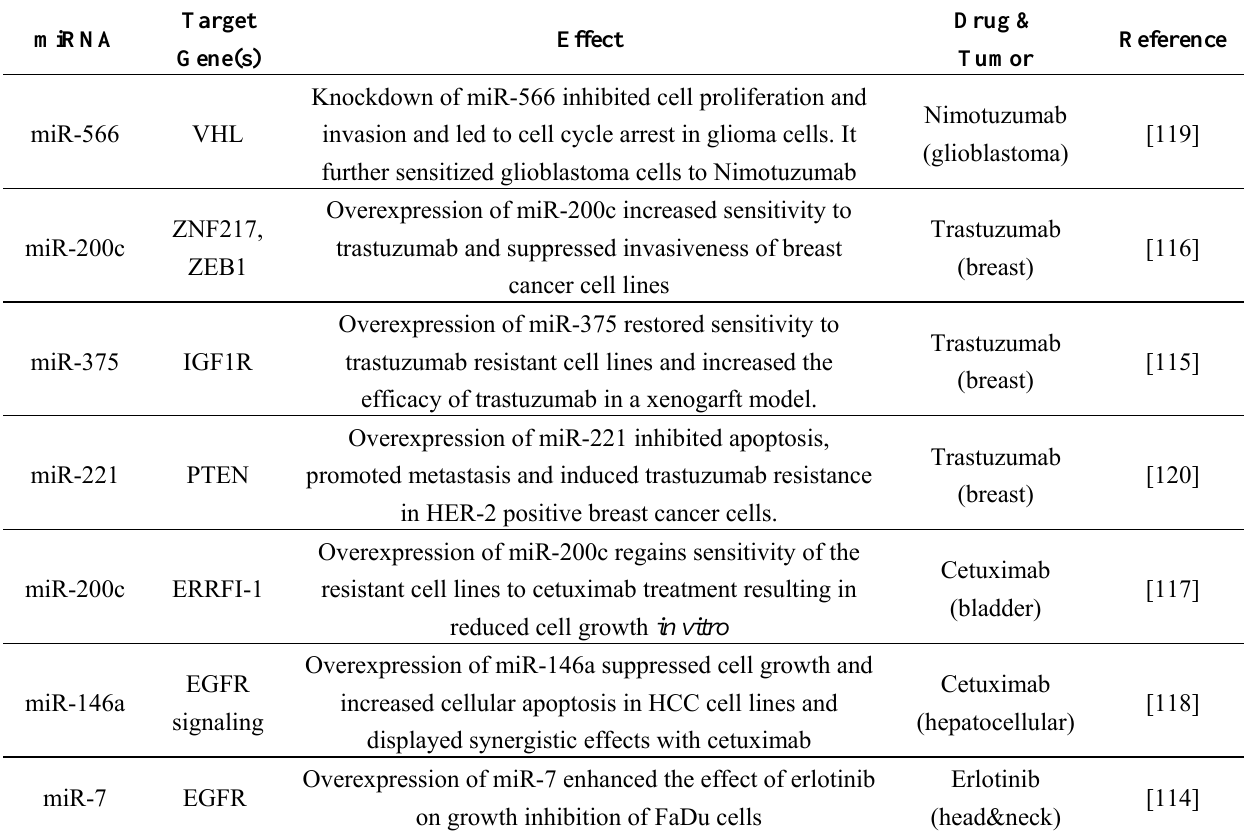
Table 1. miRNAs modulating the efficacy of monoclonal antibodies targeting receptor tyrosine